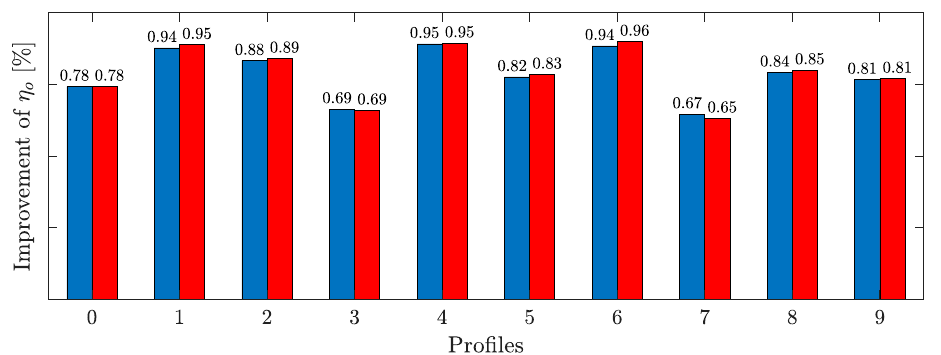
Figure 6. Propeller efficiency increase ( ∆ η o / η o ) by implementing different profiles as the PBCFs in the base design: under the same advance ratio and rotational speed (blue bar, on the left in each pair) and under the same thrust (red bar, on the right in each